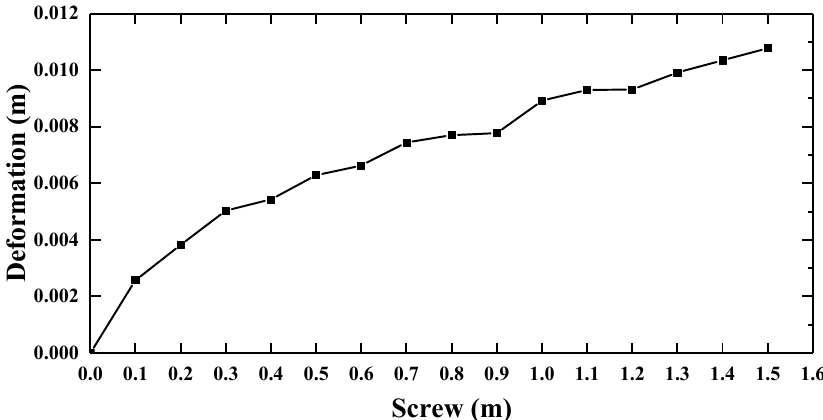
Figure 12. The radial deformation of the lead screw with a support slider.